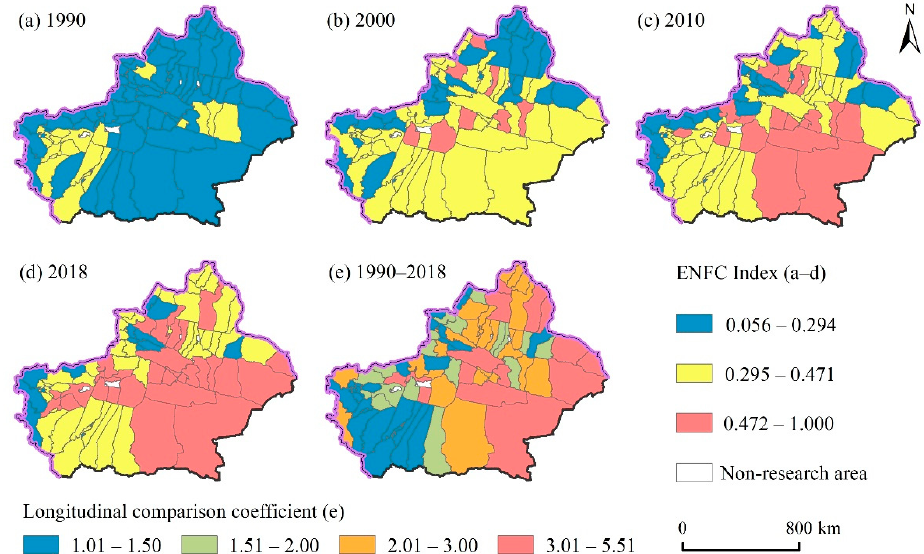
Figure 5. Temporal and spatial evolution of the ENFC at the county level in Xinjiang from 1990 to 2018: ( a ) ENFC in 1990; ( b ) ENFC in 2000; ( c ) ENFC in 2010; ( d ) ENFC in 2018; and ( e ) Changes in ENFC in 2018 compared to 1990.